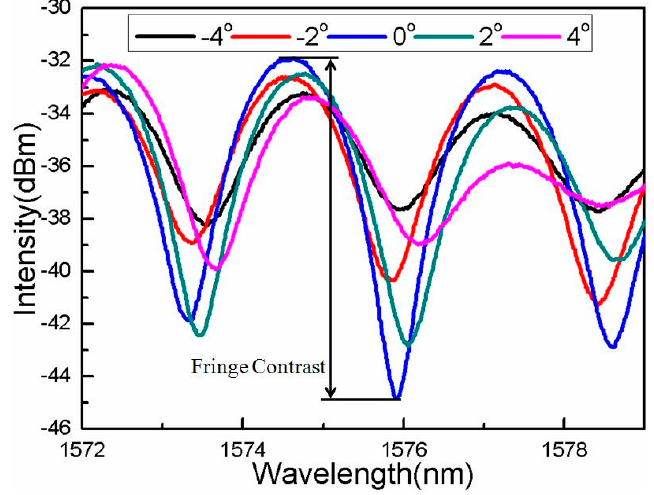
Figure 4. Interference spectral response to different bending angles.